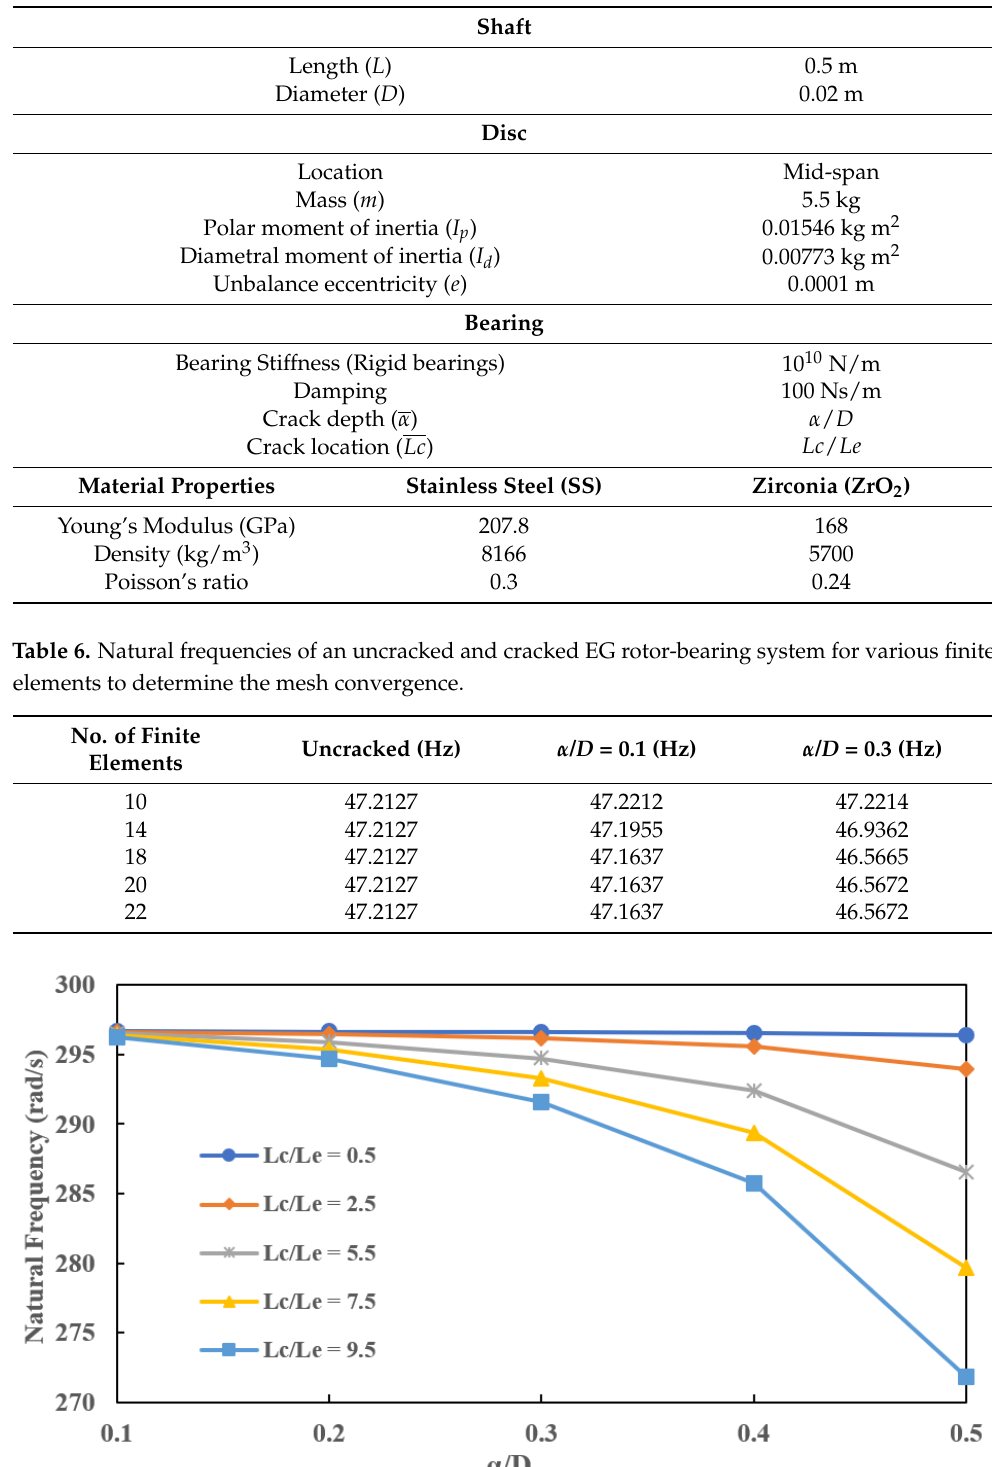
Table 5. Rotor-bearing data.